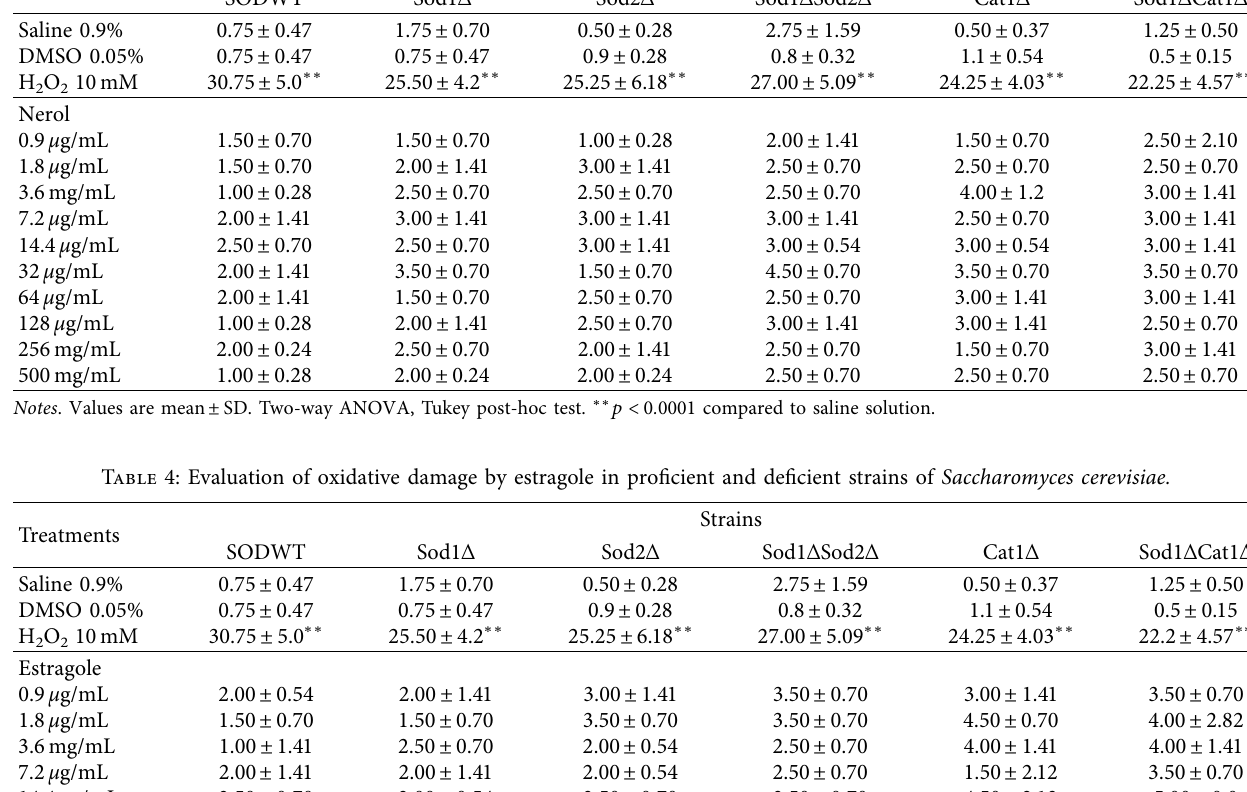
Figure 5: Ferric reduction potential of estragole, nerol, 3,7-dimethyl-1-octanol and Trolox. Notes: Values are mean ± SD of triplicate value. ∗ p < 0 . 05 vs. NC (ANOVA followed by t -Studentpost-hocNeuman-Keuls test). NC showed negligible ferric reduction capacity (1.33 ± 0.78); therefore, the value has not shown in the Table 3: Evaluation of oxidative damage by nerol in profcient and defcient strains of Saccharomyces cerevisiae. Strains Treatments